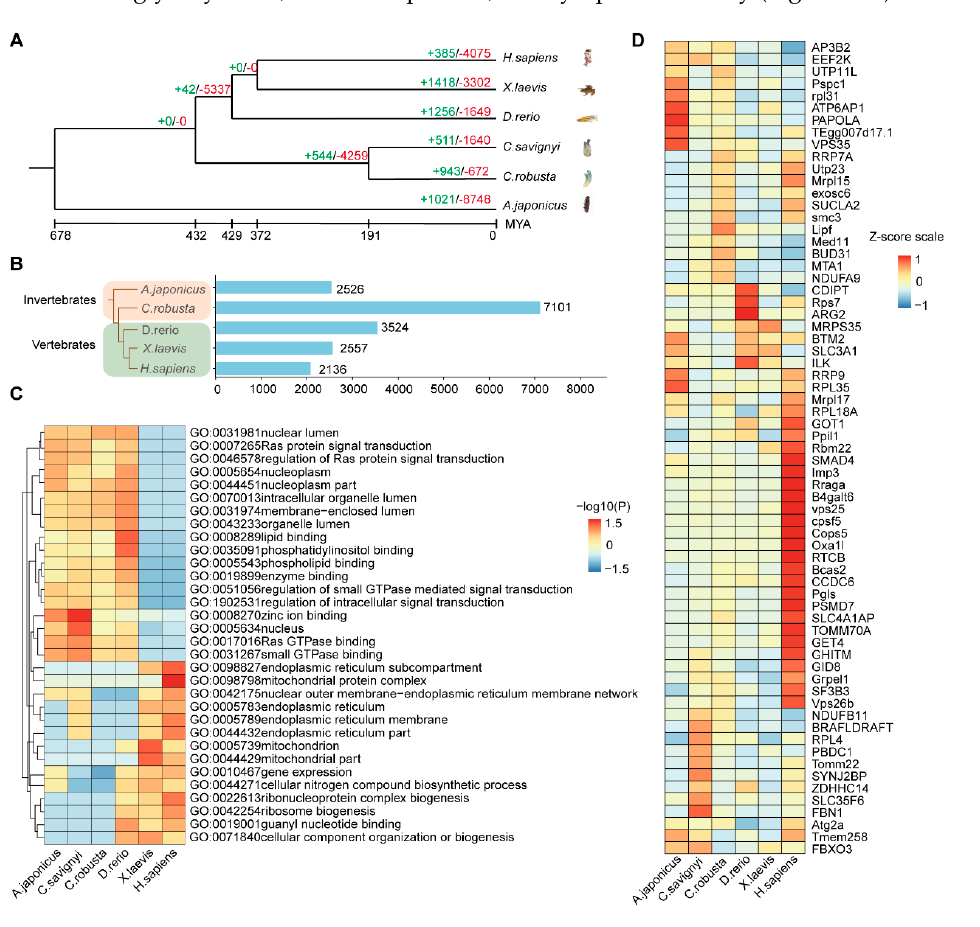
Figure 5. Conservation and divergence of intestine function during evolution. ( A ) The phylogenetic position, divergence time estimation, and gene family analysis of C. savignyi intestine. The green and red numbers indicate the expanded gene families and the contracted gene families, respectively. The divergence years are displayed below the phylogenetic tree. ( B ) Bar chart showing the numbers of intestine orthologous genes in di ff erent organisms compared with C. savignyi . ( C ) GO enrichment analysis of the orthologous genes cross-species similarities; p -value was derived by a hypergeometric test. ( D ) The heat map of single-copy orthologous genes expression in cross- species.